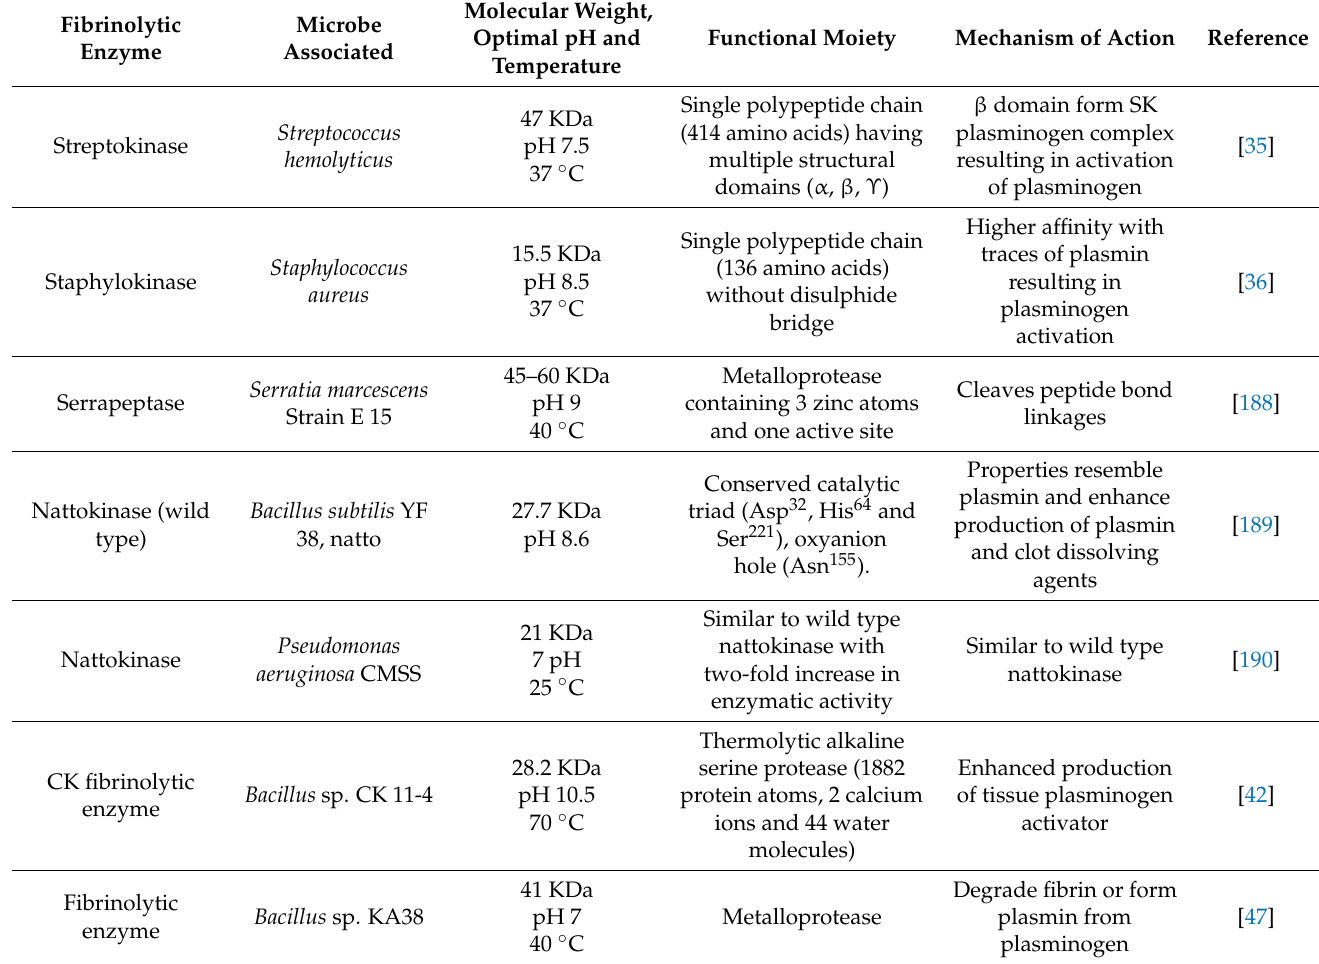
Table 3. Physiochemical properties of microbial fibrinolytic